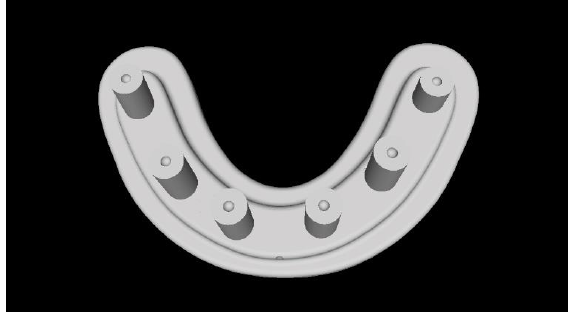
Figure 3. Computer-aided design of the model with four implants.